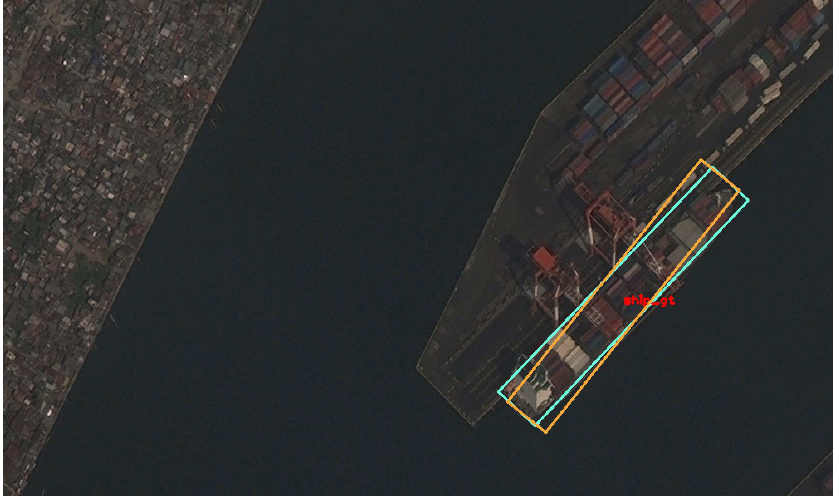
Figure 6. Different inclined rectangle boxes of